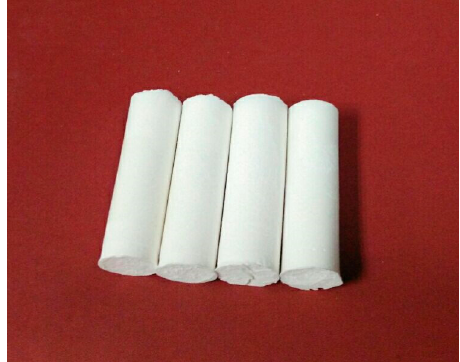
Figure 2. Macroscopic view of the nHD scaffolds.